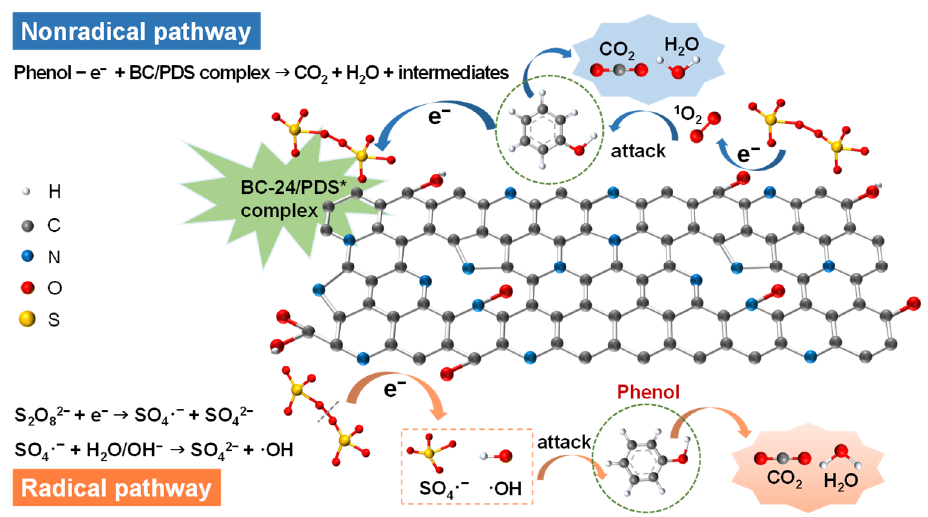
Figure 11. Proposed mechanism of phenol degradation through PDS activation on BC-24 catalyst.